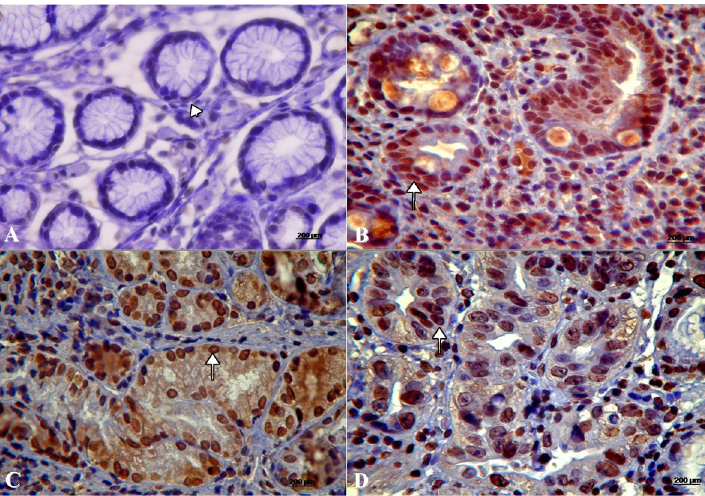
Figure 1. Immunohistochemical analysis of TERT protein in normal gastric mu- cosa showing negative expression (arrowhead, A), TERT nuclear positive im- munostaining in intestinal metaplasia (B), gastric ulcer (C), and intestinal-type gastric cancer (D). Arrows point to immunostaining nucleus. Mayer’s hematoxylin stain. Original magnification: 400X.